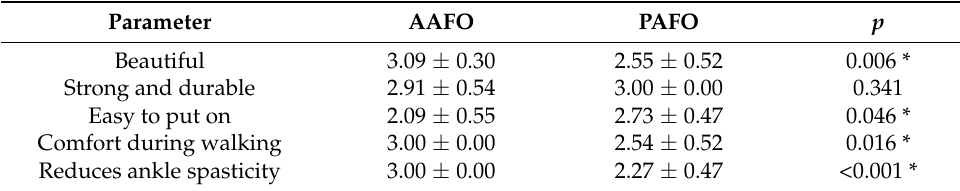
Table 2. Comparison of patient satisfaction between the AAFO and